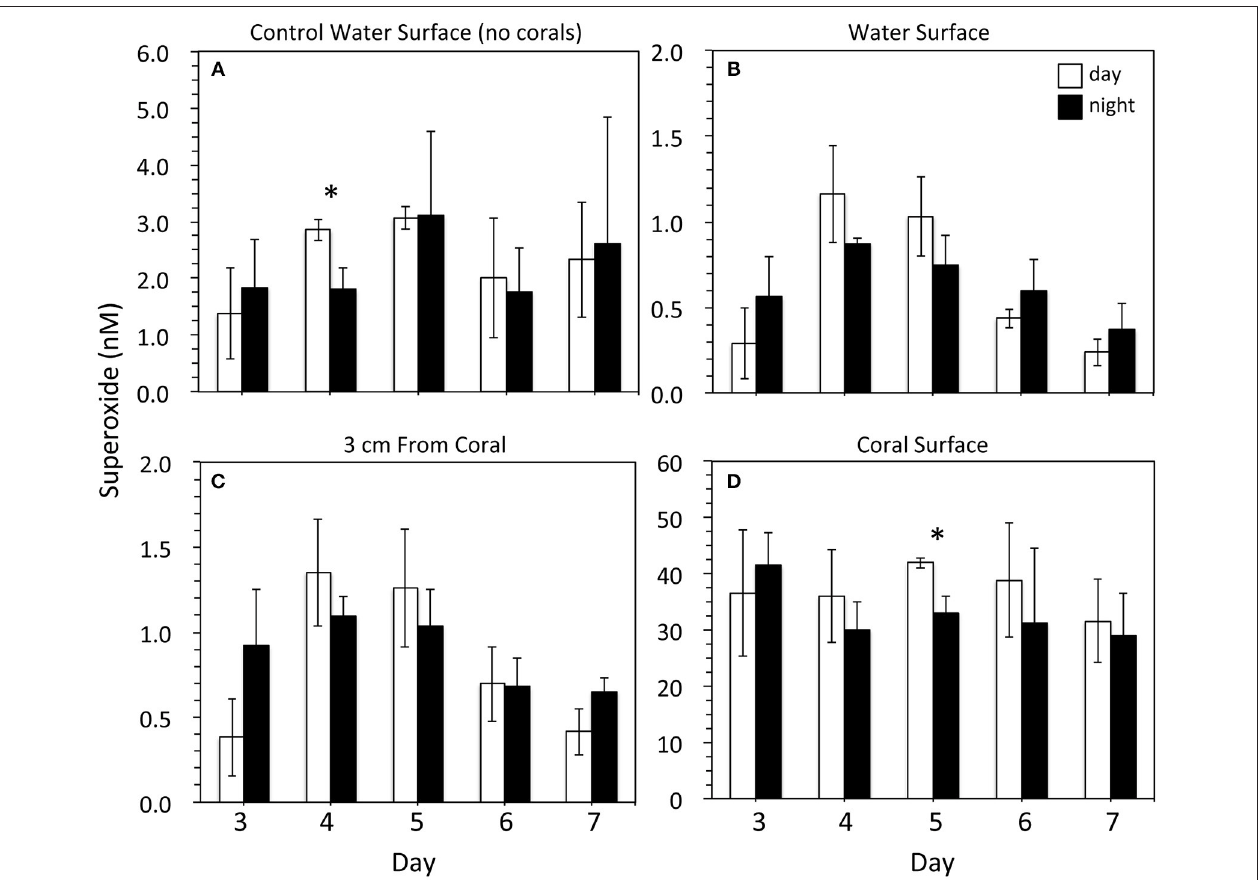
FIGURE 2 | Superoxide concentrations within (A) control tanks containing just seawater ( n = 3) and (B–D) tanks containing three Porites astreoides colonies ( n = 3). For each coral tank, measurements were taken at one position in the surface water ( B ; n = 3), 2 positions ∼ 3 cm away from the corals ( C ; n = 6), and 7 measurements at various locations along the coral surface (concentration modeled from data that were recorded for ∼ 30 s; D ; n = 21). Superoxide concentrations (mean ± SD ) were measured in the light during the day (9 am; PAR = ∼ 50 µ mol photon m − 2 s − 1 ; white bars) and in the dark at night (9 pm; PAR = 0 µ mol photon m − 2 s − 1 ; black bars). Note the difference in scale for the y-axes. Significant differences ( p < 0.05) between day and night superoxide concentrations indicated by an asterisk.